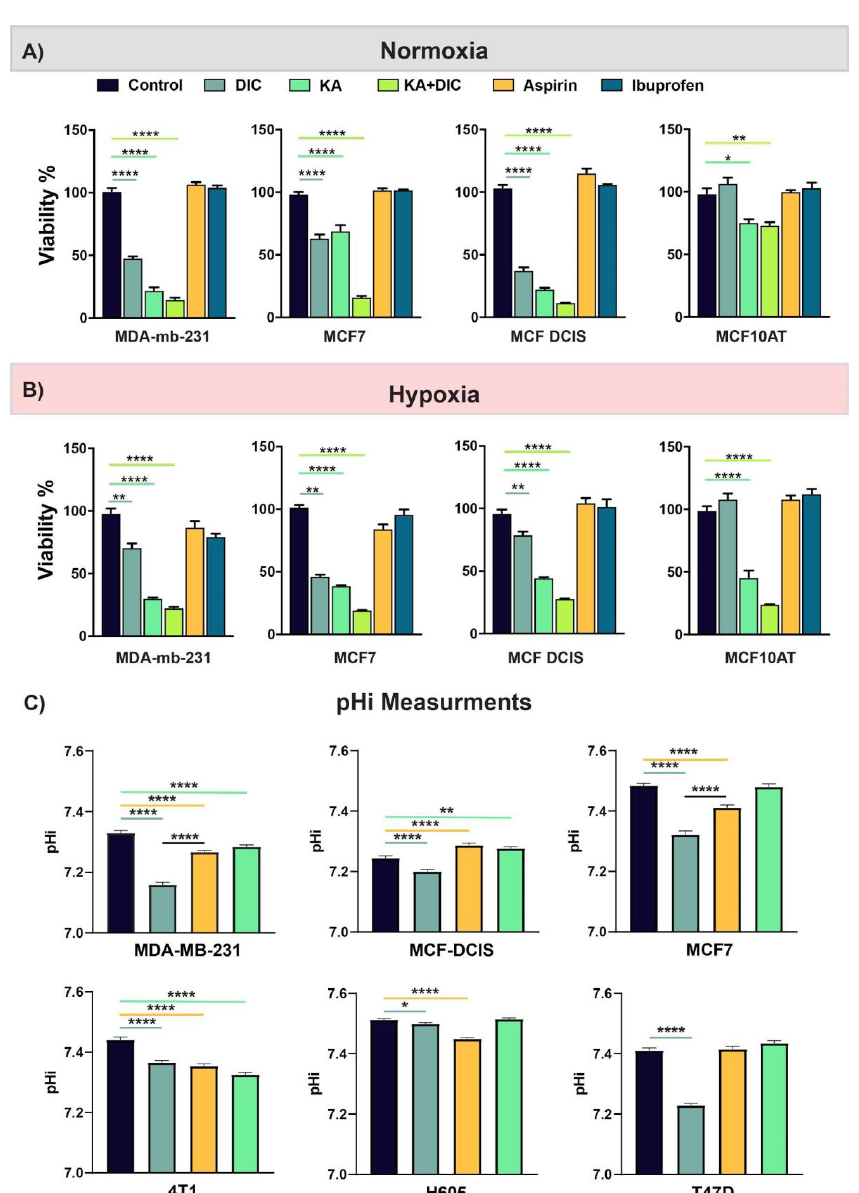
Figure 2. Diclofenac and koningic acid decrease the viability of cancer cells . ( A , B ) Viability of different breast cancer cell lines (MDA-MB-231, MCF7, MCF DCIS, MCF10AT) were measured in 2D using CCK8 kit under normoxia ( A ) and hypoxia ( B ) and different treatments. Diclofenac combination with GAPDH inhibition had the highest effect on cell viability. Interestingly other NSAID drugs such Aspirin or Ibuprofen didn’t have any effect on cell viabilities. Error bars plotted as SD. ( C ) Intracellular pH measurement of MDA-MB-231, MCF-DCIS, MCF7, 4T1, H605, and T47D cancer cells using SNARF1, after 16 h treatment. Diclofenac decreased the pHi significantly in all cell lines. Error bars plotted as SEM. p -values are represented as follows: * p < 0.05, ** p < 0.01, **** p < 0.0001.